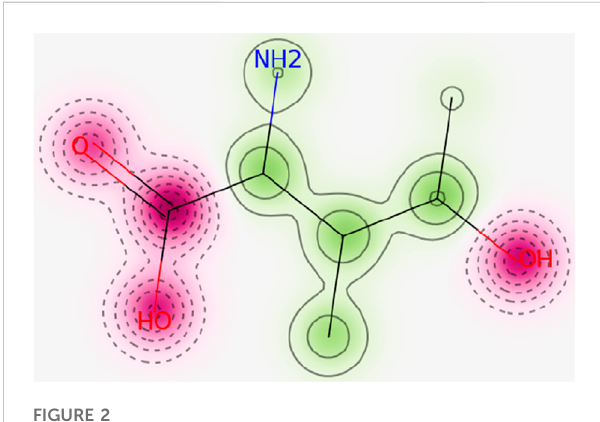
FIGURE 2 In the probability map of hERG blockage (Pred-hERG web tool), the red dotted lines re fl ect non-hERG blocker. Contour lines with intense green color indicate a higher positive contribution of an atom to hERG blockade.